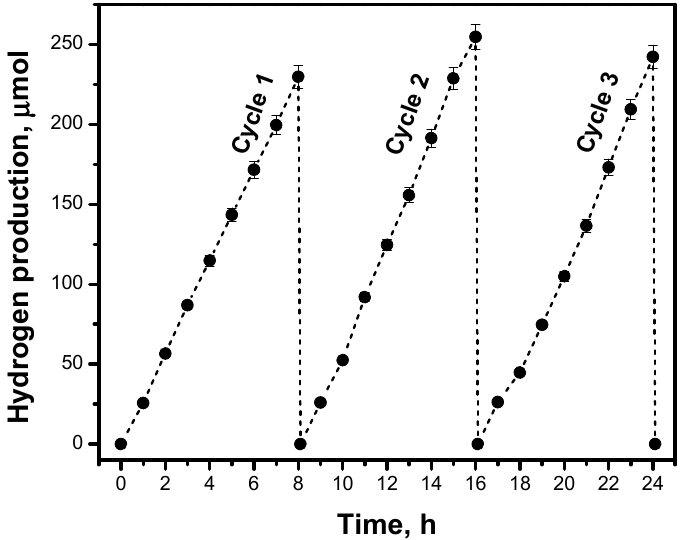
Figure 8. Stability test of the 1.0 Cu/Ti 500 photocatalyst during three continuous cycles in the same water–hydrazine solution.